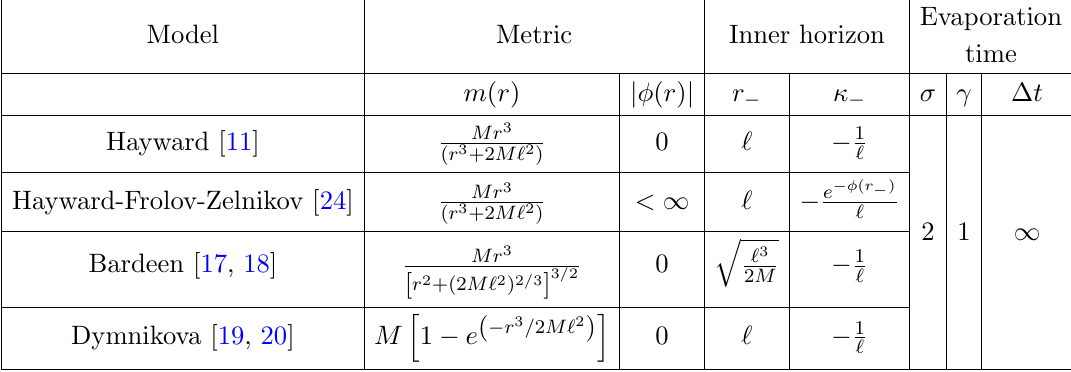
Table 1 . The most relevant properties of the examples that we have considered. The parameter ‘ is a length scale, which is usually identi(cid:12)ed with the Planck length. Only the leading order of r (cid:0) and (cid:20) (cid:0) is provided, so that these quantities must be multiplied by [1 + O ( ‘=M )]